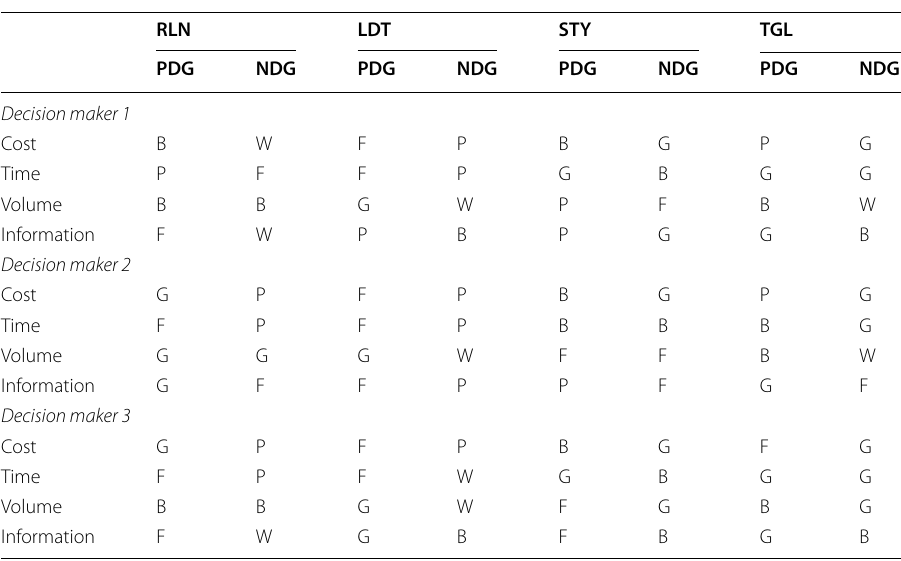
Table 11 Evaluations for